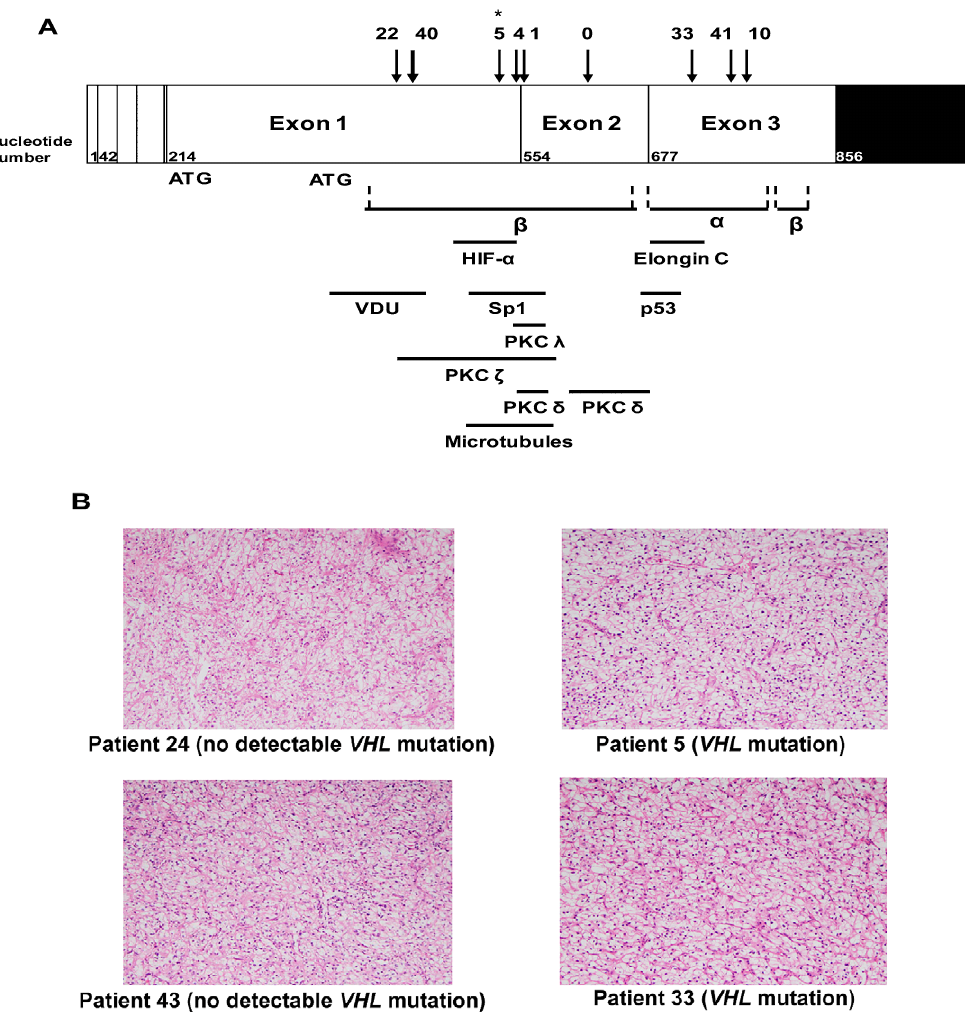
Fig. 1. Schematic illustration of the location of identified VHL mutations, H&E staining of CCRCC tissue sections and VHL transcript analysis in paired CCRCC tissue samples. (A) The first translation initiation codon is located at Nt. 214 with a second initiation codon at Nt. 373 (nucleotide numbering according to GenBank sequence NM_000551.2). The 5 (cid:2) untranslated region (UTR) (hatched region) in exon 1 and the 3 (cid:2) UTR (blackened region) in exon 3 are depicted. An arrow represents the location of each patient’s mutation. Mutations were located within the defined functional domains of pVHL. The lower part of the schematic shows the location of the α and β domain and the major protein binding sites of pVHL including HIF, elongin C, VDU (VHL interacting deubiquitinating enzyme), Sp1, p53, PKC ( δ , ζ , λ (protein kinase C)) and microtubules. (B) H&E staining of CCRCC paraffin embedded tissue sections from two patients without detectable VHL mutations and two patients with VHL mutations. (C) Relative quantification of the VHL transcript level in nine patients’ normal renal and tumour tissue. The ‘Delta–Delta’ formula was used to determine the ratio of VHL transcript expression between each of the paired normal and tumour samples [25]. β -actin was used as a control reference gene. Expression Ratio = 2 − ( Δ C p sample( C p Target − C p Reference) − Δ C p control( C p Target − C p Reference)) . (2 – real-time PCR amplification efficiency; C p – crossing point; sample – tumour; control – corresponding normal tissue; target – VHL ; reference – β -actin). For comparison purposes the expression level of VHL in a normal renal tissue (control) is given a value of 1 and the expression level of VHL in the corresponding tumour is compared to it. Using this formula, a two-fold down-regulation of VHL would have a relative expression ratio of < 0.5 as indicated by the dotted line (data not shown). Patient names are plotted versus the expression ratio as determined using the above formula. Error bars represent standard error of the mean. * – two different mutations were identified in this patient’s tumour tissue. spectively and were absent in normal renal tissues tients without VHL genetic alterations, HIF-1 α and HIF-2 α were detected in 8 and 10 patient tumours re- in all VHL genetically altered tumours. In the 10 pa- spectively. Mean tumour diameter ranged in size